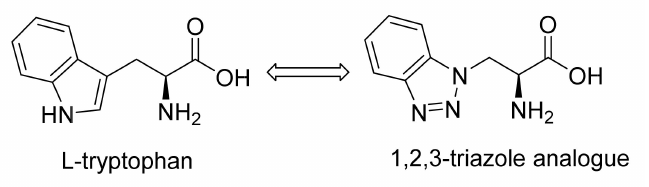
Figure 12. L -tryptophane and its triazole analogue.